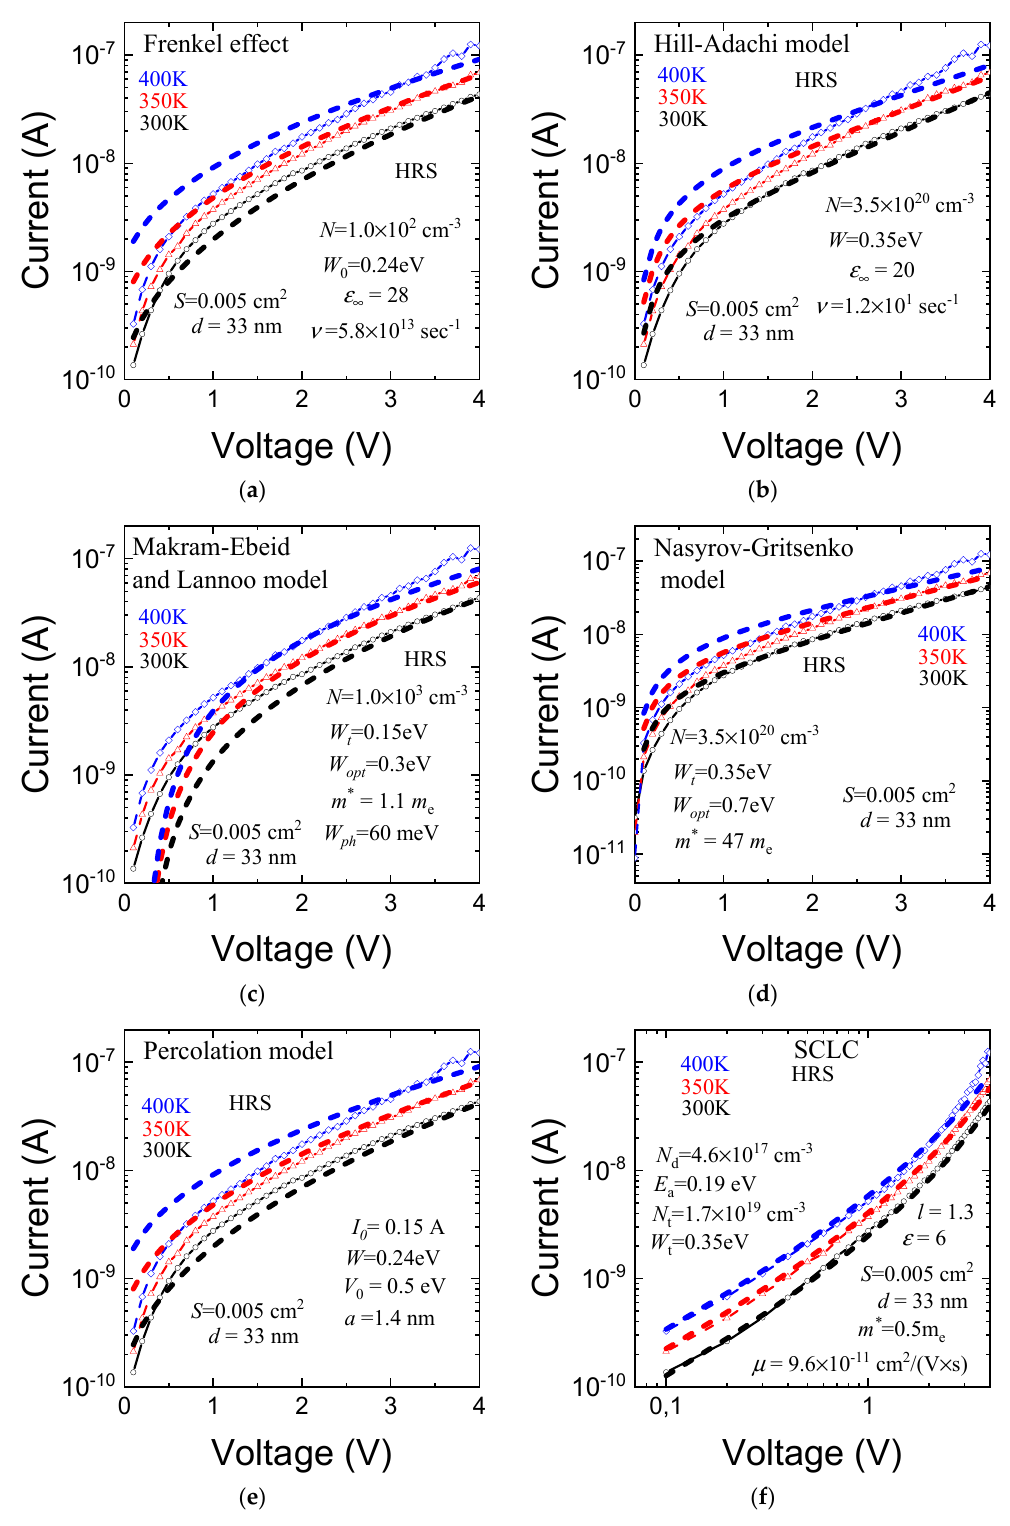
Figure 6. IV characteristics of the PECVD SiO 0.9 N 0.6 -based memristor, and the results of simulation by the bulk-limited models in HRS: ( a ) Frenkel effect; ( b ) Hill–Adachi model of overlapping Coulomb potentials; ( c ) Makram–Ebeid and Lannoo multiphonon isolated trap ionization model; ( d ) Nasyrov– Gritsenko model of phonon-assisted tunneling between traps, ( e ) Shklovskii–Efros percolation model; and ( f ) the SCLC